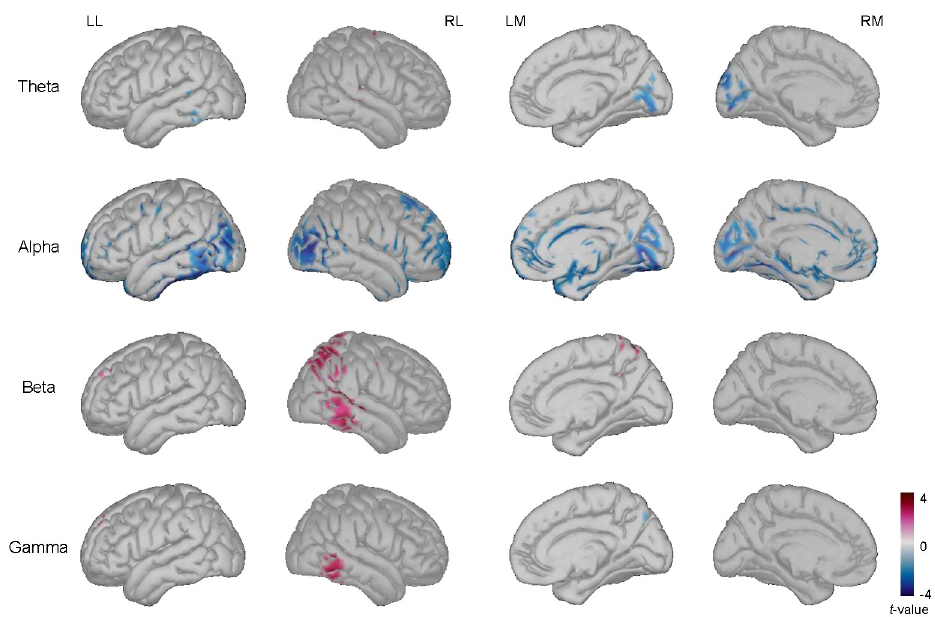
Fig 6. Significant difference between the power of later remembered items vs. forgotten items during stimulus presentation for encoding task. The t -values in theta, alpha, beta, and gamma bands when comparing the power in later remembered items and forgotten items at 400–800 ms during the presentation of the stimulus (two-tailed paired t -test, p < 0.05 with Bonferroni correction). LL = left lateral view; RL = right lateral view; LM = left medial view; RM = right medial view.